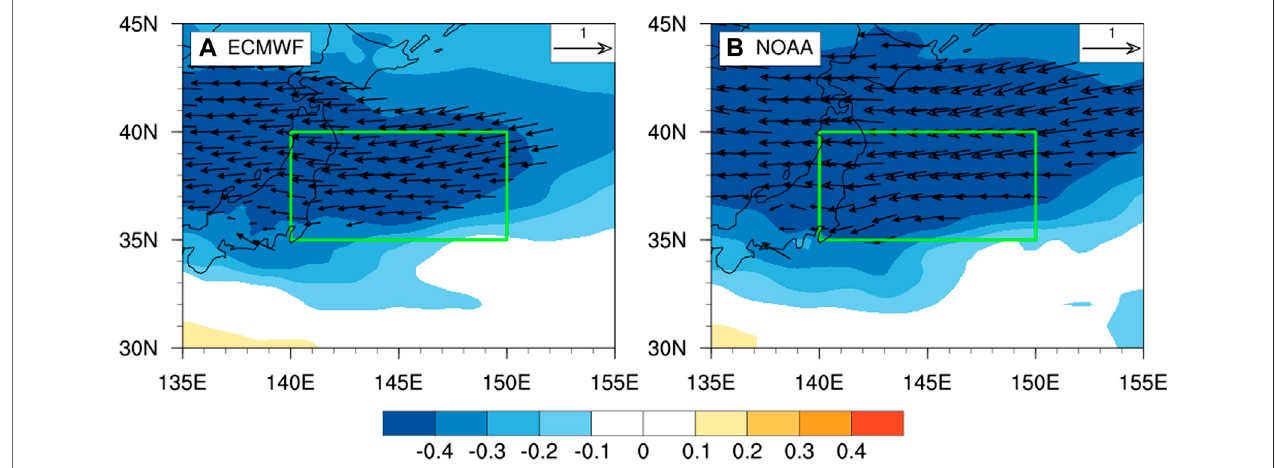
FIGURE 5 | Regression(vector;unit:m s − 1 )andcorrelation(shading)oftheMarch850-hPawindanomaliesonthenumberofTClandfallsusing (A) ECMWF(1979 – 2005) and (B) NOAA data (1982 – 2005). Either zonal wind or meridional wind statistically signi fi cant at the 95% con fi dence level are shown. Shading indicates the areas where the correlation coef fi cients of the zonal wind anomalies are signi fi cant at the 95% con fi dence level. The regions of U850 EJ,3 are speci fi ed by the green rectangles.